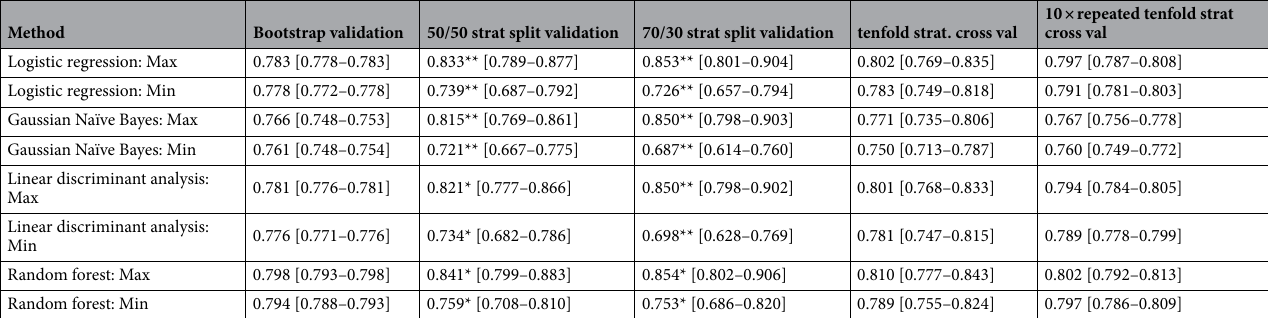
Table 1. 95% AUC estimate/confidence intervals (CI) for maximum and minimum cases (Cedars). 95% CI calculated using Delong method with concatenated predictions. For bootstrap validation, AUC computed as mean from the AUC of the 500 iterations, sometimes falling out of range of 95% CI. CI calculated using Delong method in brackets. *Signifies measured statistical significance p-value < 0.05 in independent ROC comparison to max–min counterpart for the same algorithm and validation technique. **Indicates p-value < 0.01 in independent ROC comparison. ROC receiver operating characteristic curve, AUC area under the ROC curve.